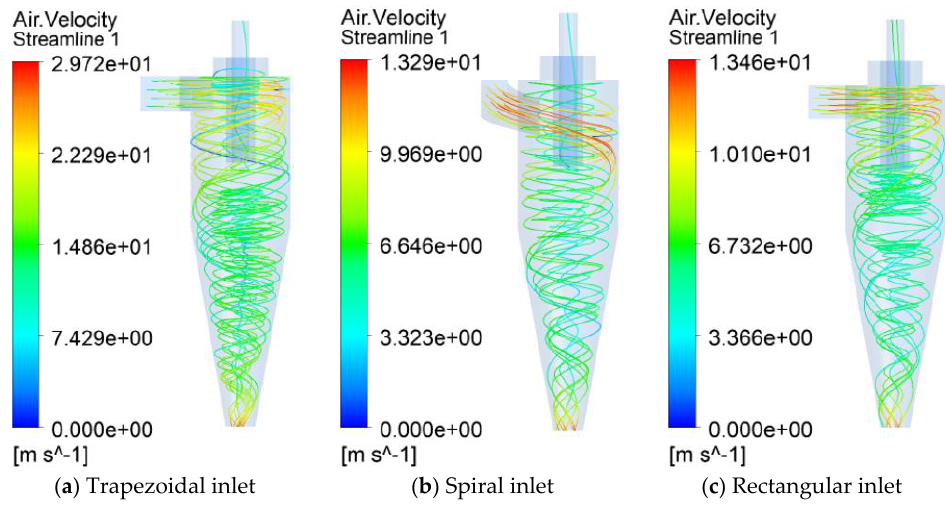
Figure 10. Distribution of bubble motion in longitudinal section.